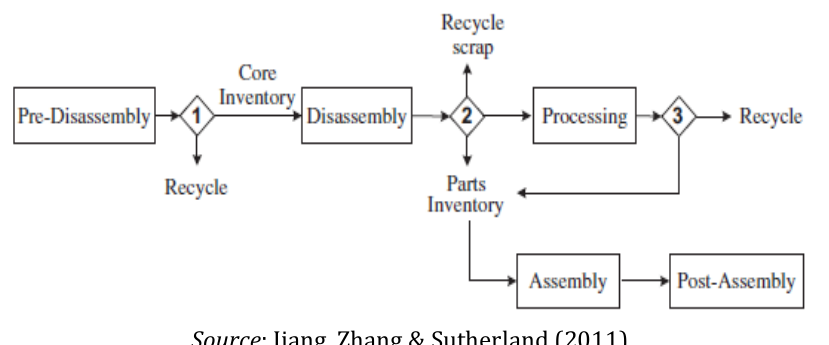
Source : Jiang, Zhang & Sutherland (2011) Figure 14: Disassembly-assembly oriented remanufacturing system can enhance technical viability of remanufacturing-upgrading of CNC milling comparing with